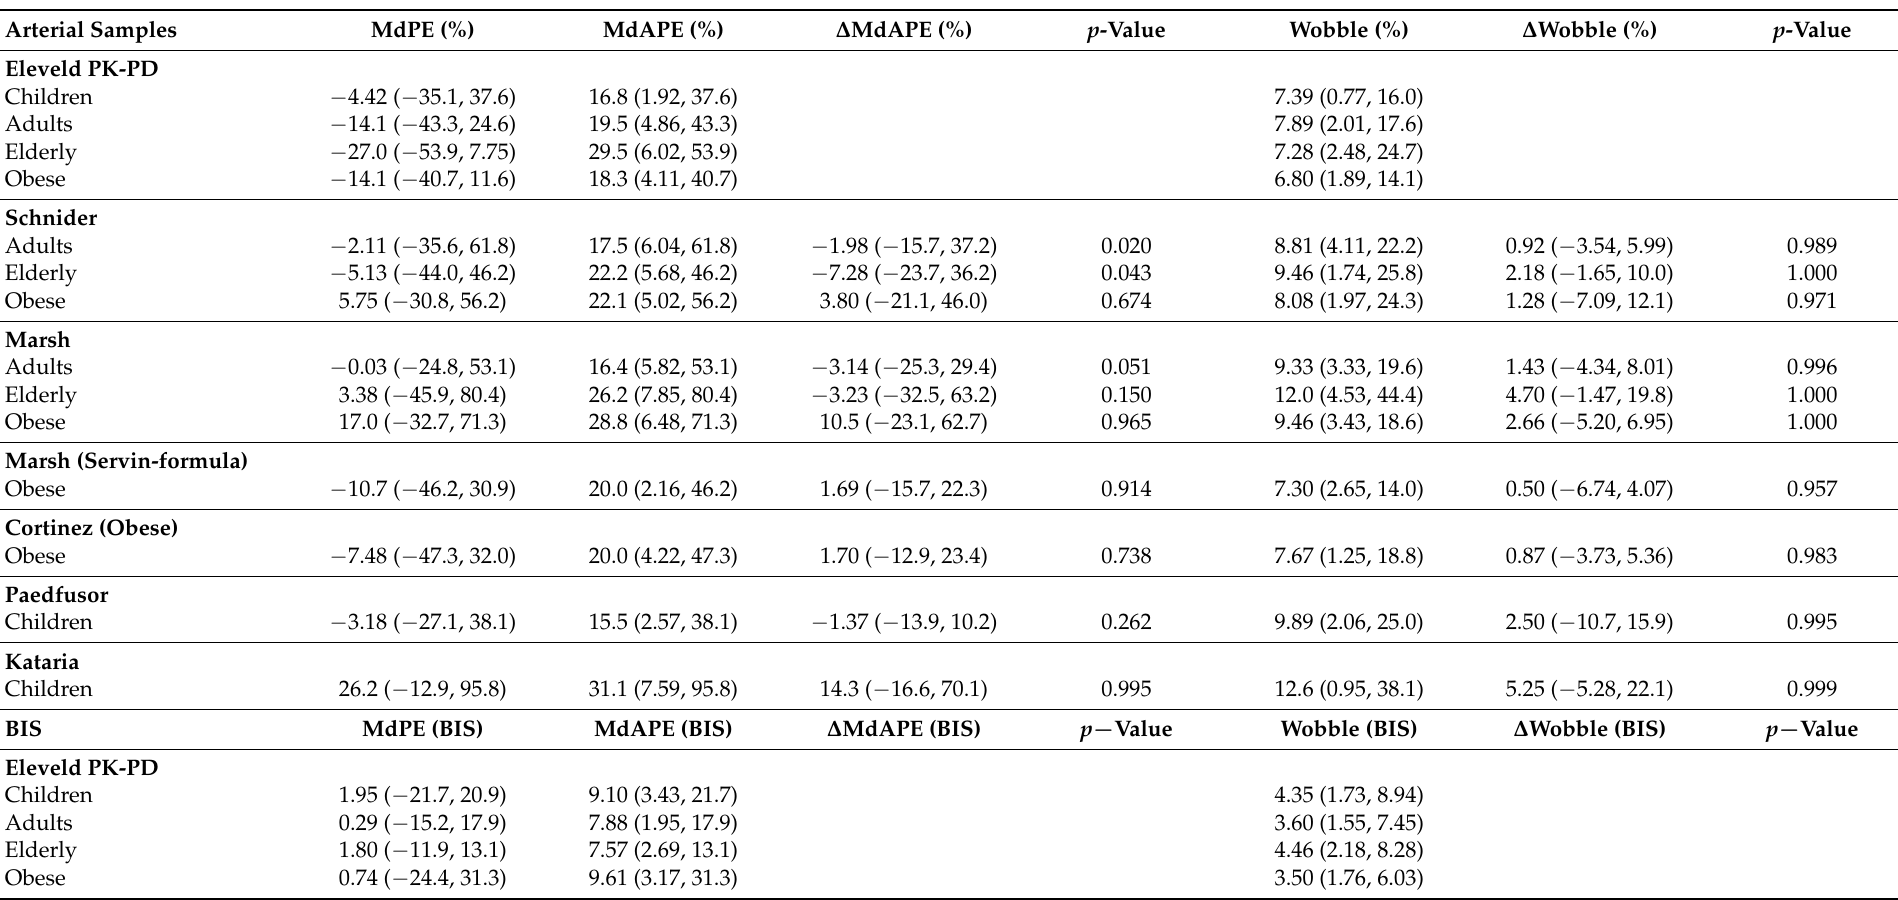
Table 2. The predictive performance for PK (plasma concentrations) and PD (BIS) of the Eleveld PK-PD model compared to other propofol models. (Reproduced with permission [71], 2020, British Journal of